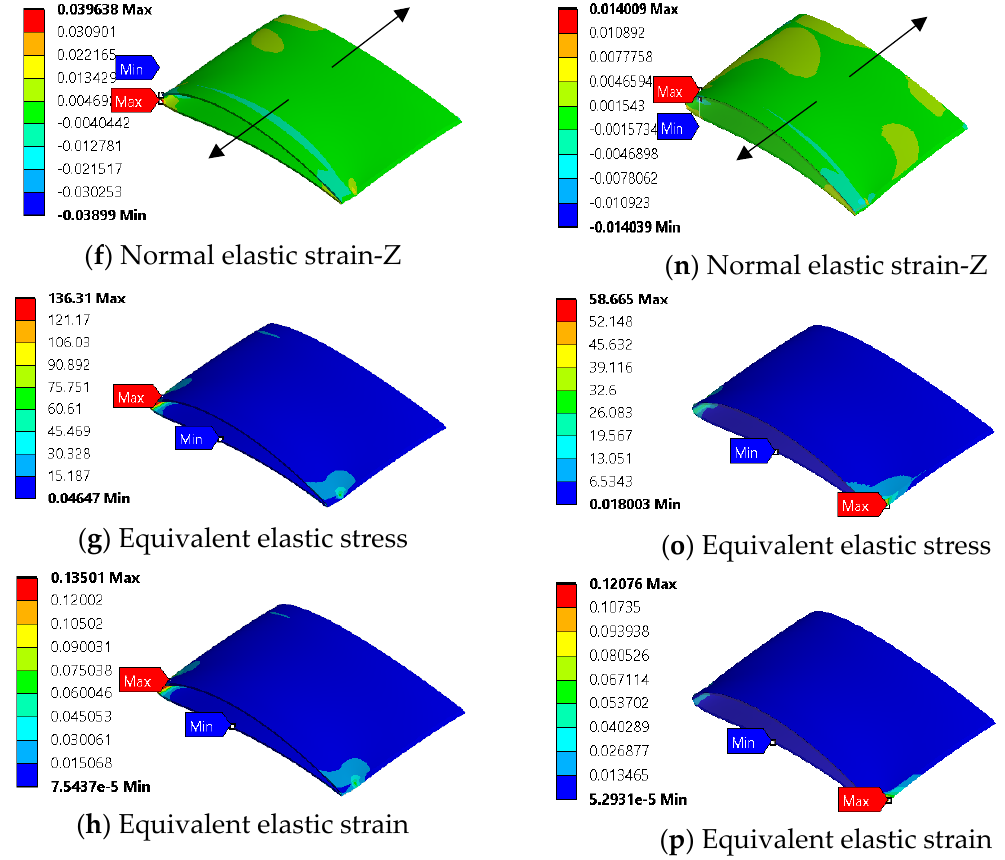
Figure 5. Wing model bulk material elastic stresses (MPa) and elastic strains for 6% camber rate ( a–h ) internal skin, ( i – p ) external skin. Table 3. Bulk material mechanical properties related to wing model 6% camber